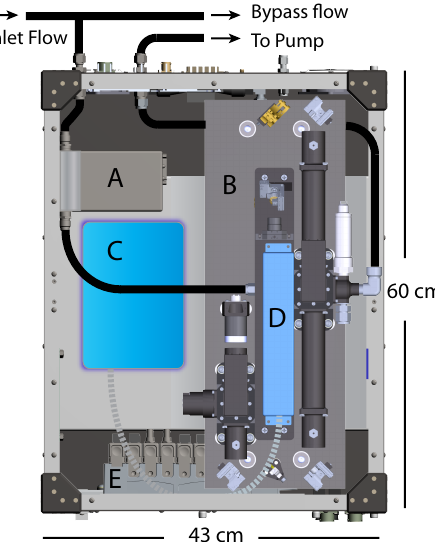
Figure 2. A top view of the ISAF instrument layout. The instru- ment chassis is 60 × 43 × 35cm and 25kg. The major subsystems are labeled: (A) pressure controller, (B) optical bench, (C) tunable fiber laser, (D) harmonic generation housing, and (E) data acquisi- tion